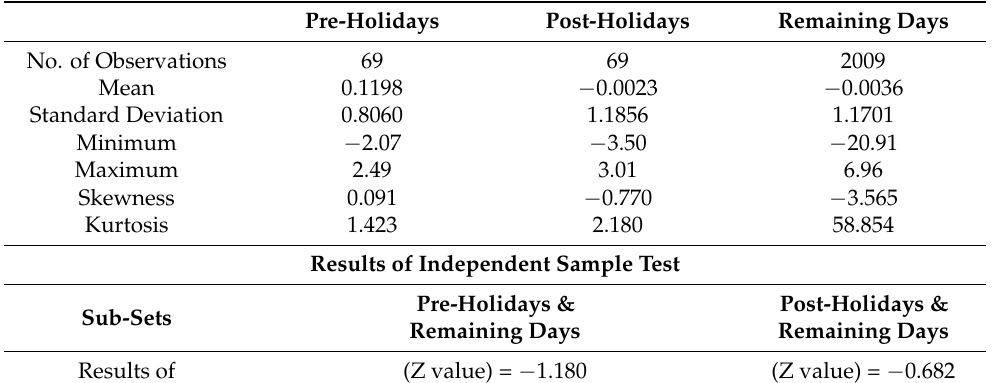
Table 6. The Results of Descriptive Statistics for FTDKUW Daily Returns for Pre, Post-Holiday